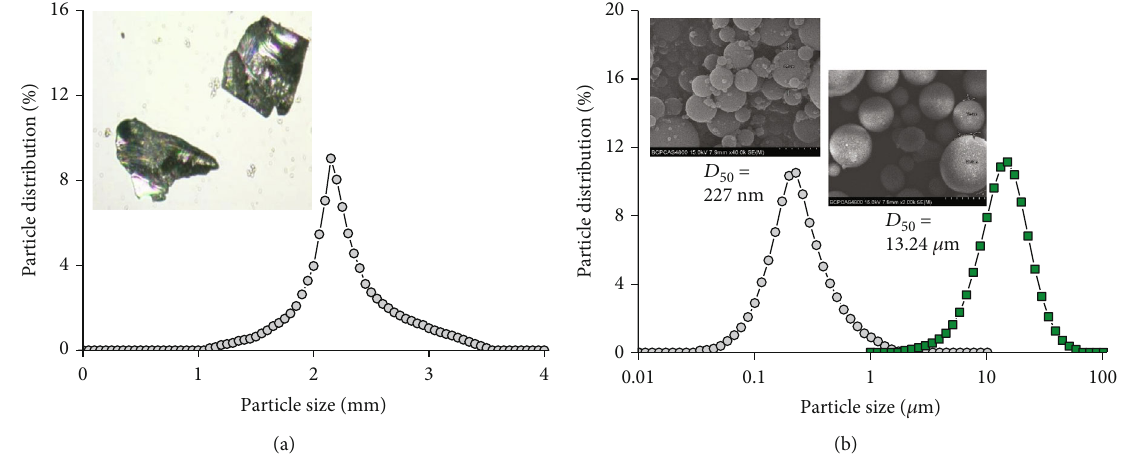
Figure 2: Particle gradation curves of the test materials: (a) quartz sand and (b) silicon